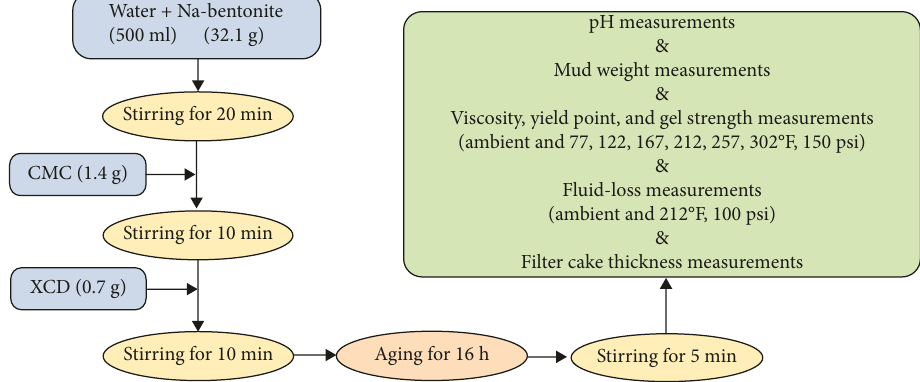
Figure 2: Flowchart of the experimental